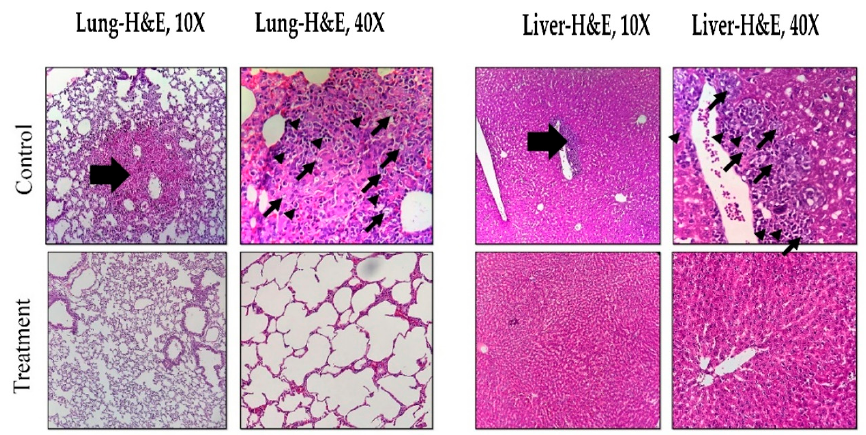
Figure 5. Histopathological images of lung and liver tissues in control and treatment (MNPs + AMF) groups. Thick arrows show microscopic tumor metastasis in lung and liver, thin arrows represent tumor cells, and arrowheads: inflammatory cells.